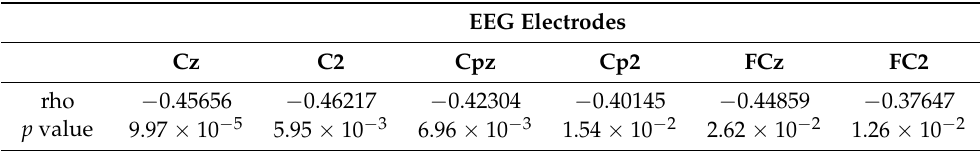
Table 2. Correlation coefficients of the alpha wave with oxyHb in the RPMCdr cortical area during left flexion (LF).